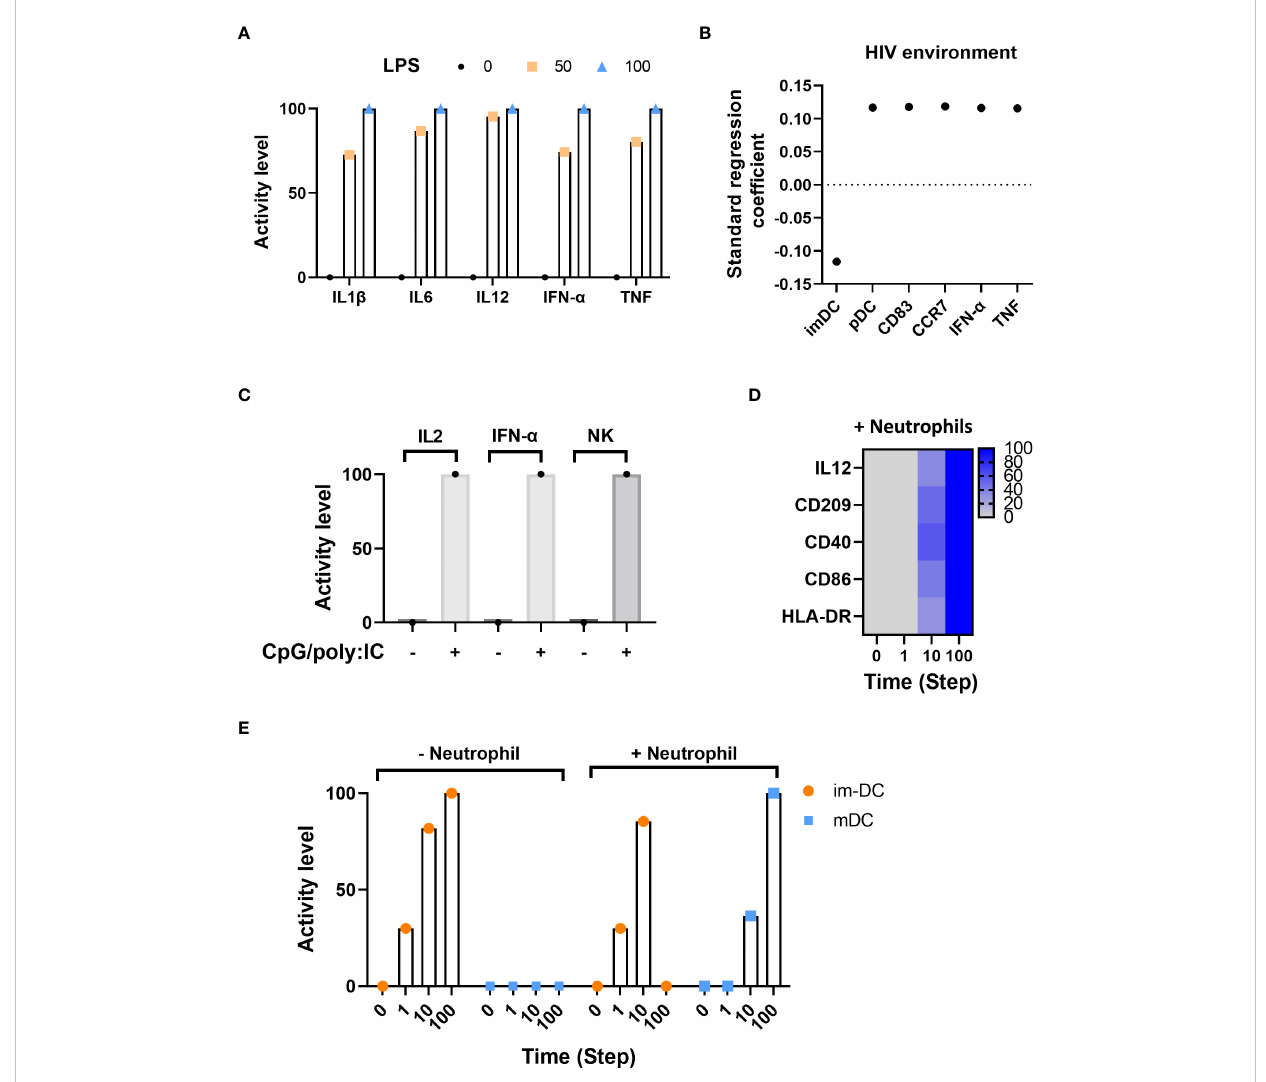
FIGURE 3 In-silico model validations. (A) In fl ammatory cytokine activity level in response to LPS using dose-response analysis. (B) Standard regression coef fi cient of main factors activated in the HIV infection environment. (C) Activity level of IL2, IFN- a and NK under CpG-containing oligonucleotides and poly(I:C) stimulation. (D) Markers of maturation at different time points in the presence of neutrophils. (E) Time course distribution of DC immature (im-DC) and mature (mDC) states with (+) or without (-)